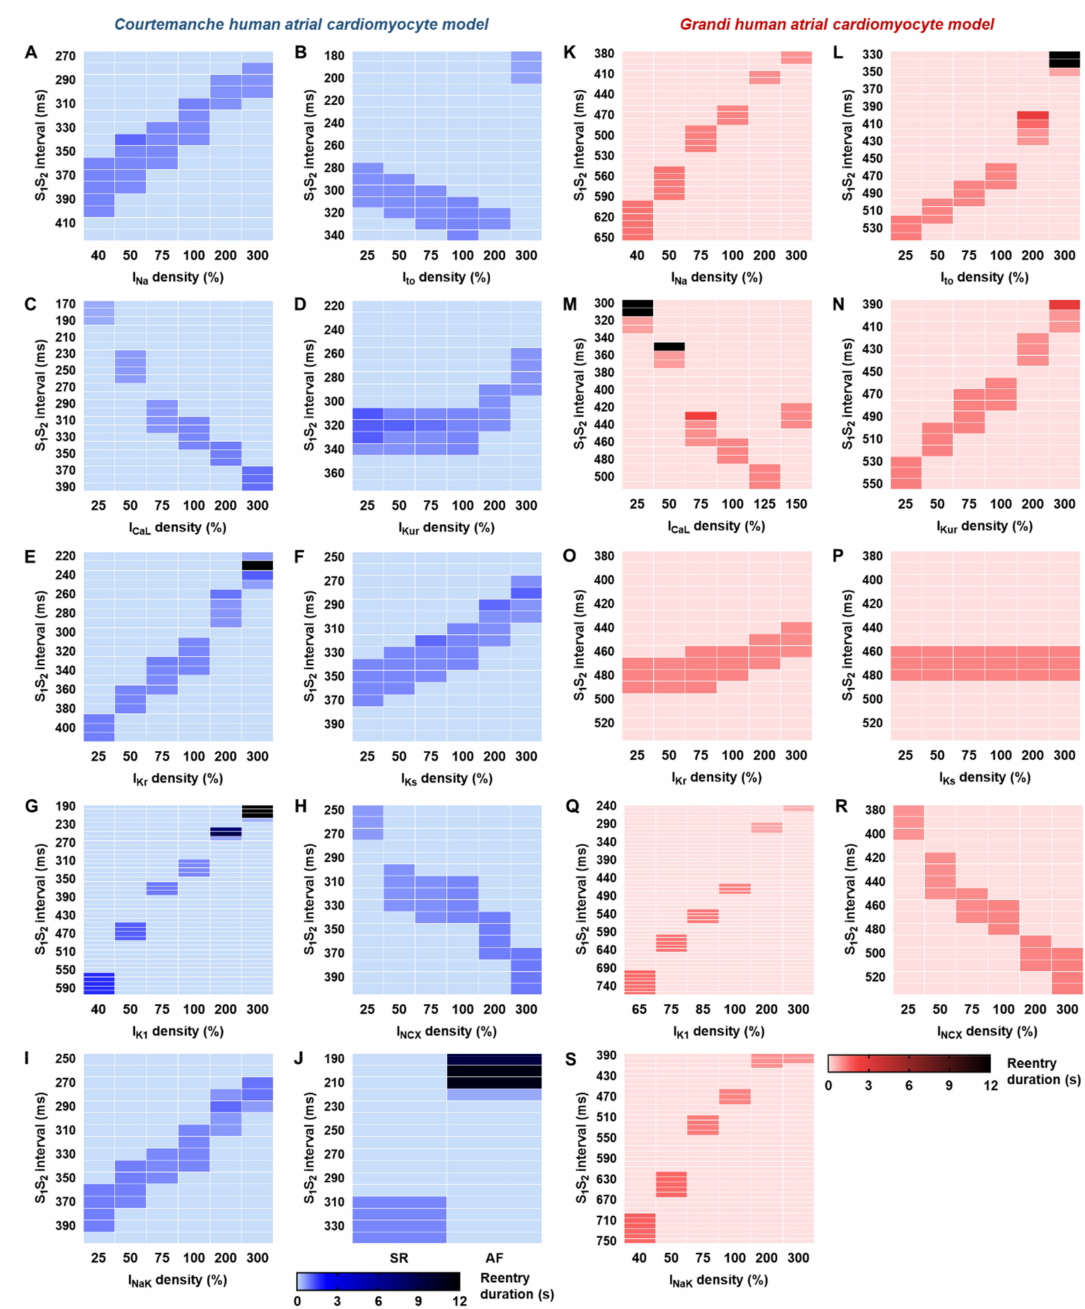
Figure 3. Individual contributions of atrial ionic currents on reentrant waves behavior. Vulnerable windows depicting the effects of perturbations of nine atrial ionic currents on spiral waves generation, maintenance and termination in the Courtemanche ( A – I ) and Grandi human atrial cardiomyocyte ( K – S ) models. ( J ) The effect of previously documented AF-related ion-channel remodeling [7] on cardiac